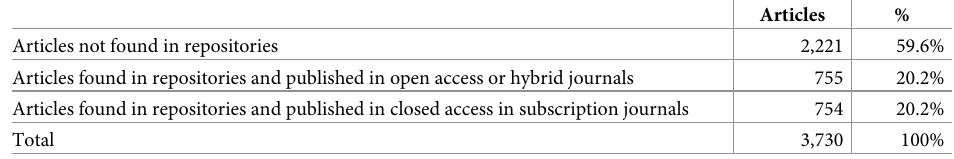
Table 9. Articles in